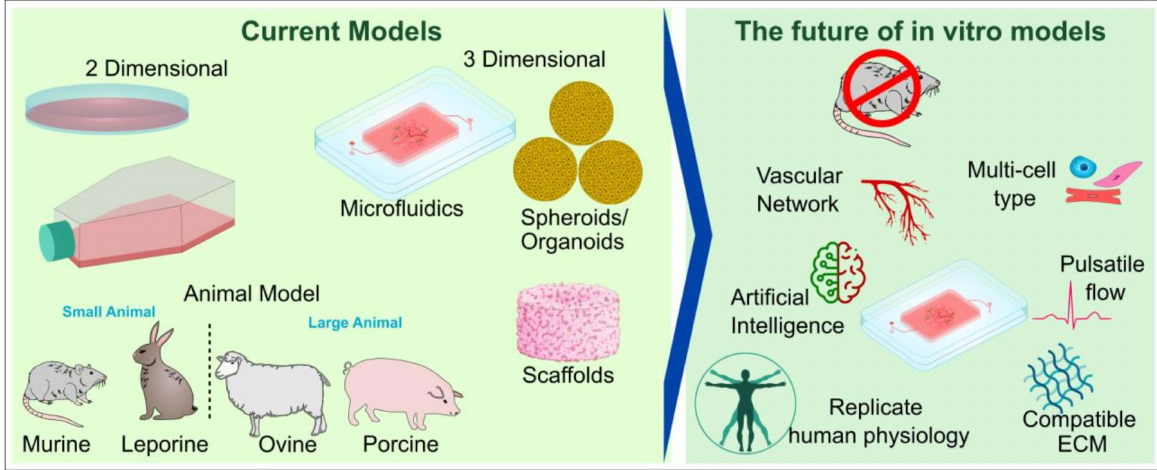
Figure 12. The future of in vitro models: a